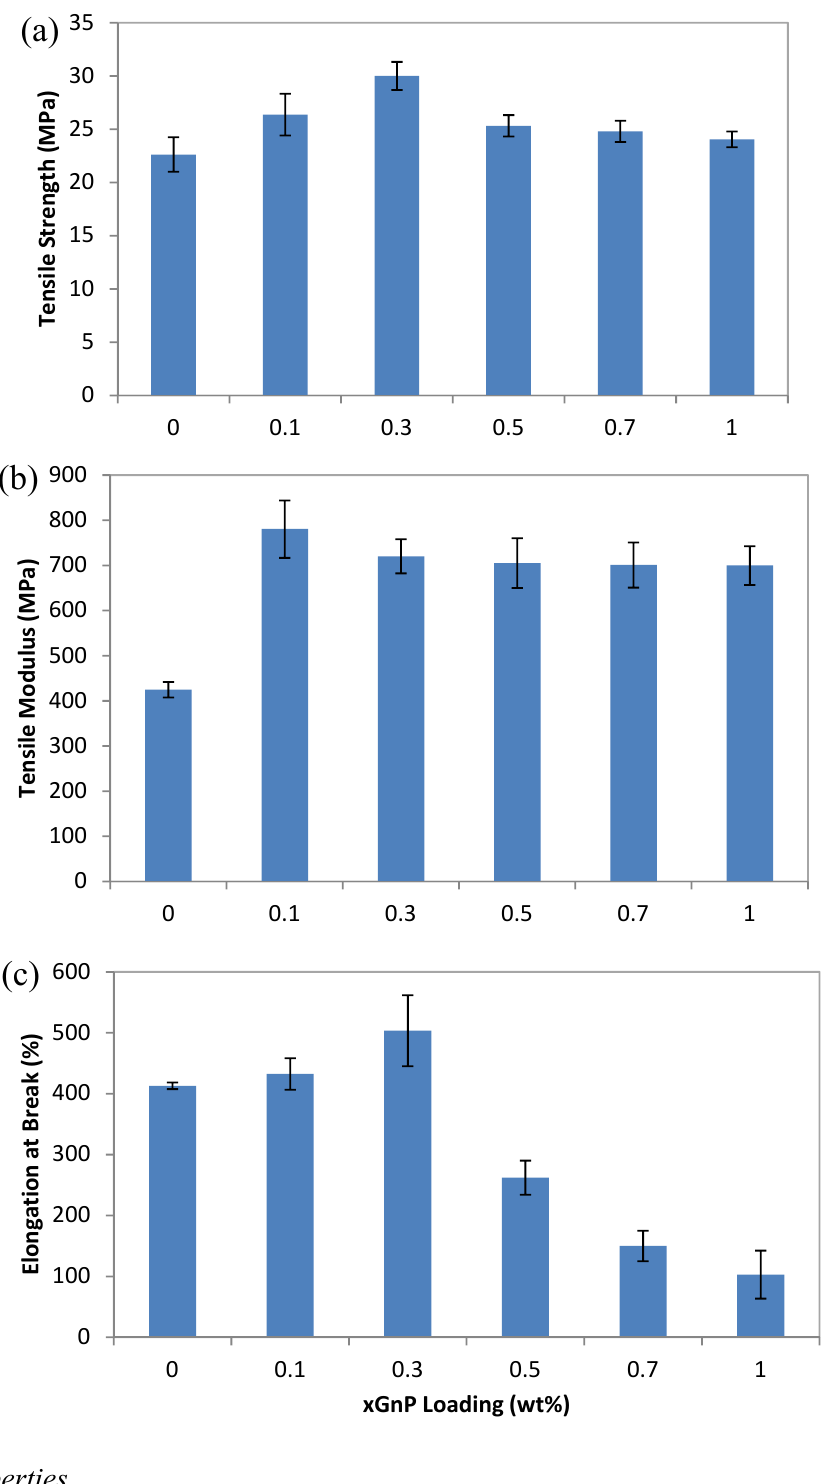
Figure 5. ( a ) Tensile strength; ( b ) tensile modulus; and ( c ) elongation at break of PLA/PEG/xGnP nanocomposites as a function of xGnP loading. (Confidence Interval C.I.